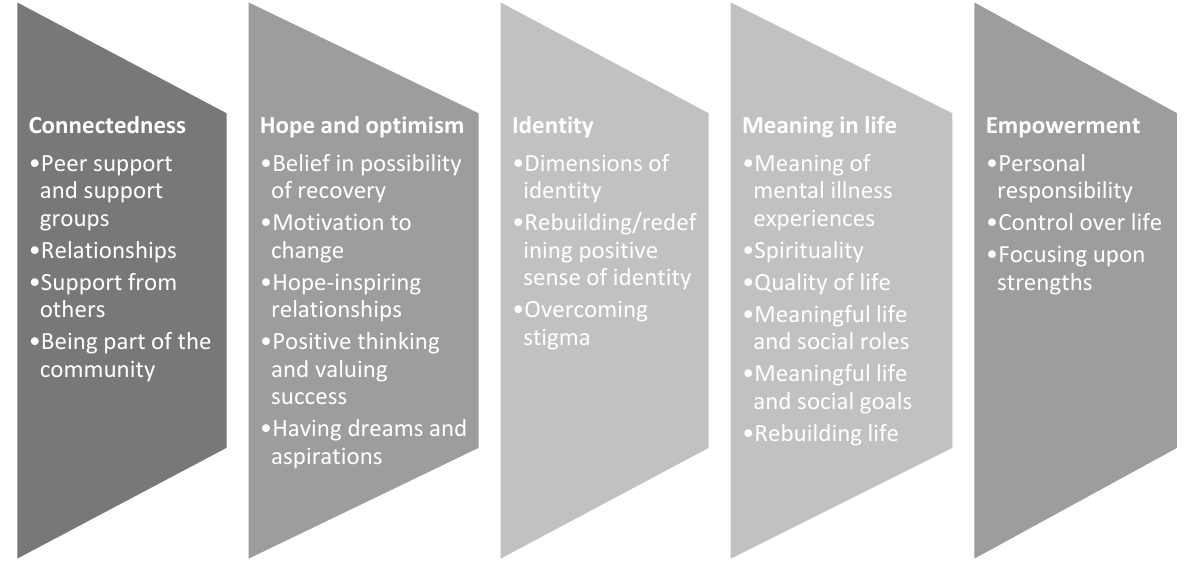
Figure 1. Processes of adult recovery (CHIME; Leamy et al., 2011) .